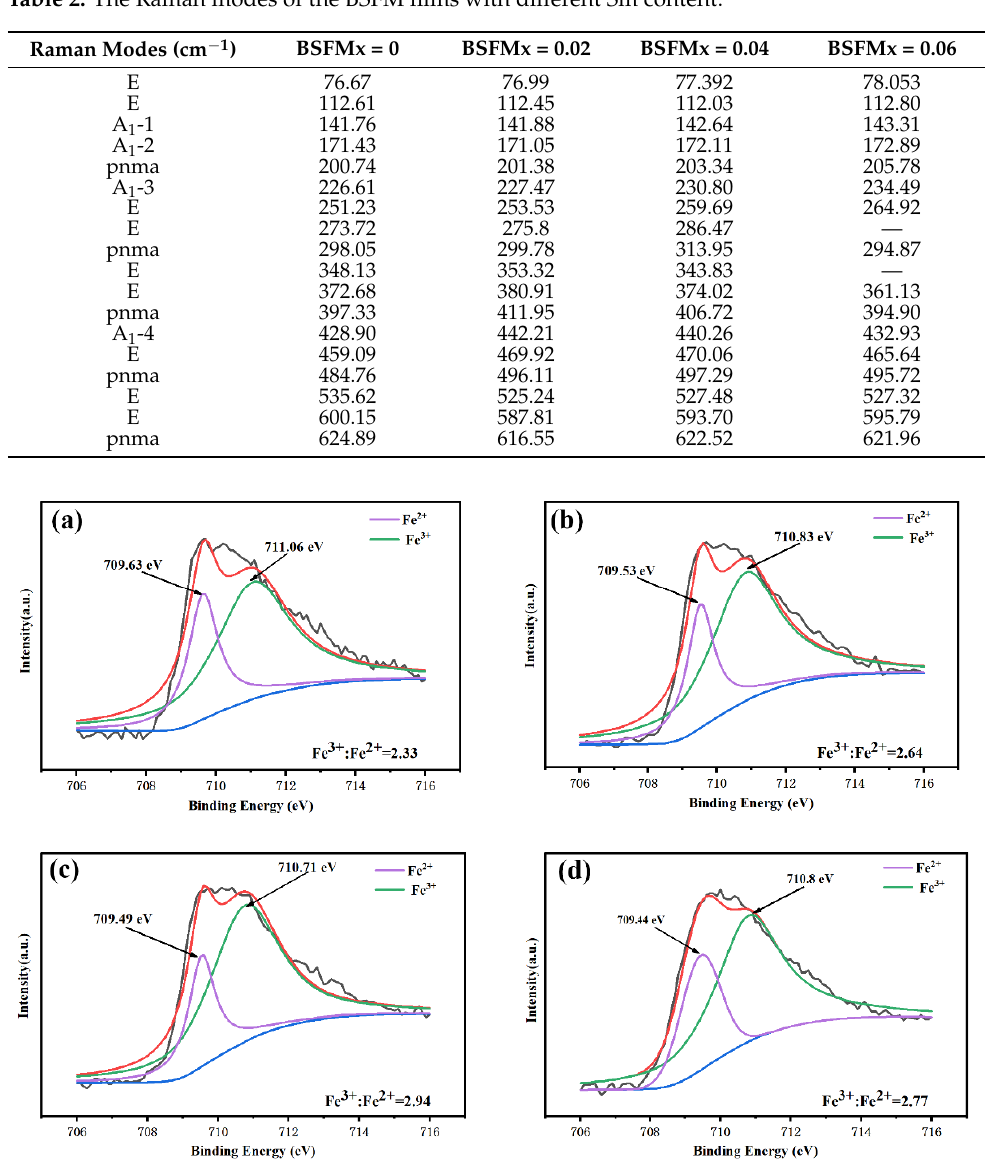
Figure 5. Fe2p 3/2 orbital XPS fitting diagram of the BSFM films with different Sm content: ( a ) x = 0 mol%; ( b ) x = 2 mol%; ( c ) x = 4 mol%; ( d ) x = 6 mol%. The black lines refer to the original curve, the red lines refer to the fitting curve, and the blue lines refer to the background line.